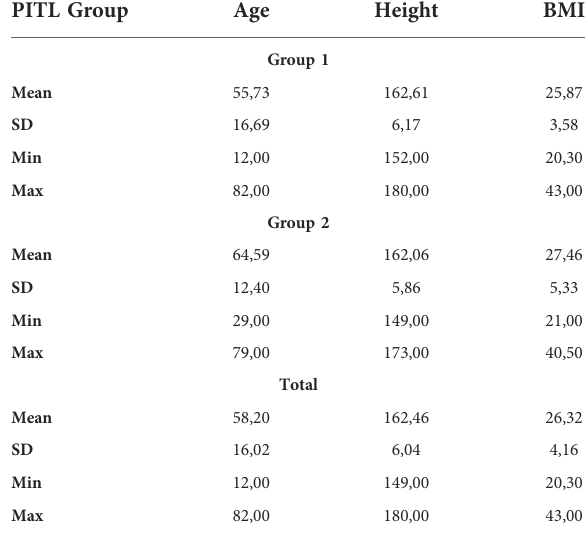
TABLE 3 Descriptive statistics across PITL